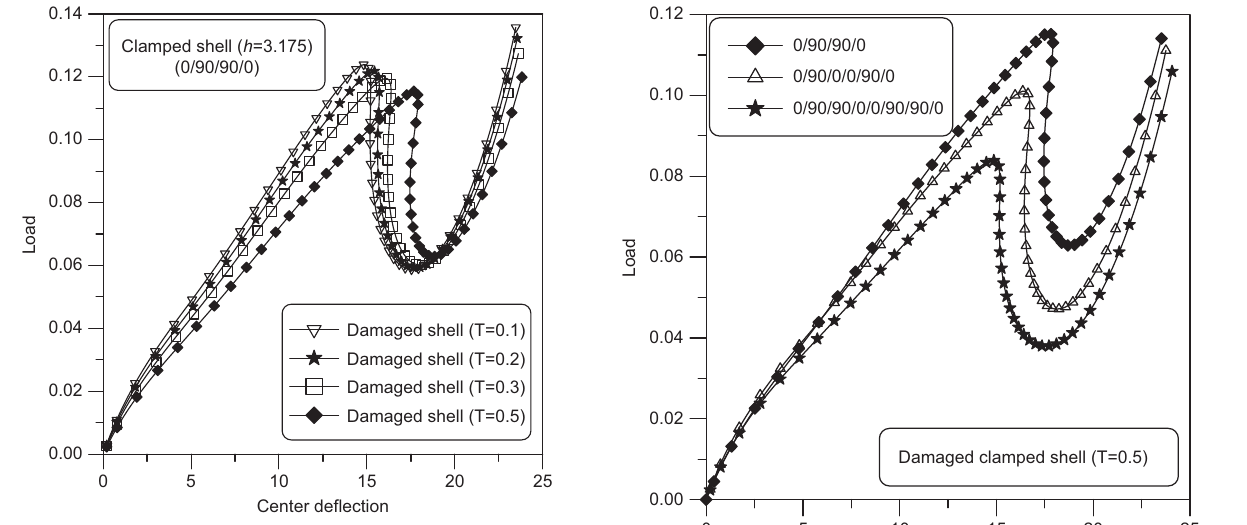
Figure 14 Load-displacement curves of clamped cylindrical shell.